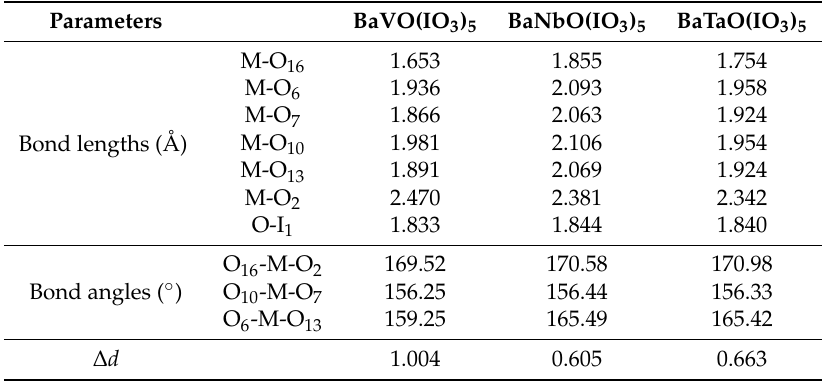
Table 4. Bond lengths, bond angles, and ∆ d in BaMO(IO 3 ) 5 (M = V, Nb and Ta).